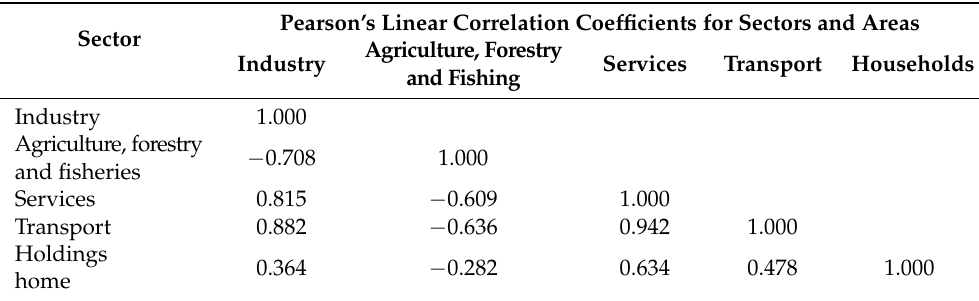
Table 4. Pearson’s linear correlation coefficient values for individual sectors and areas in EU countries in